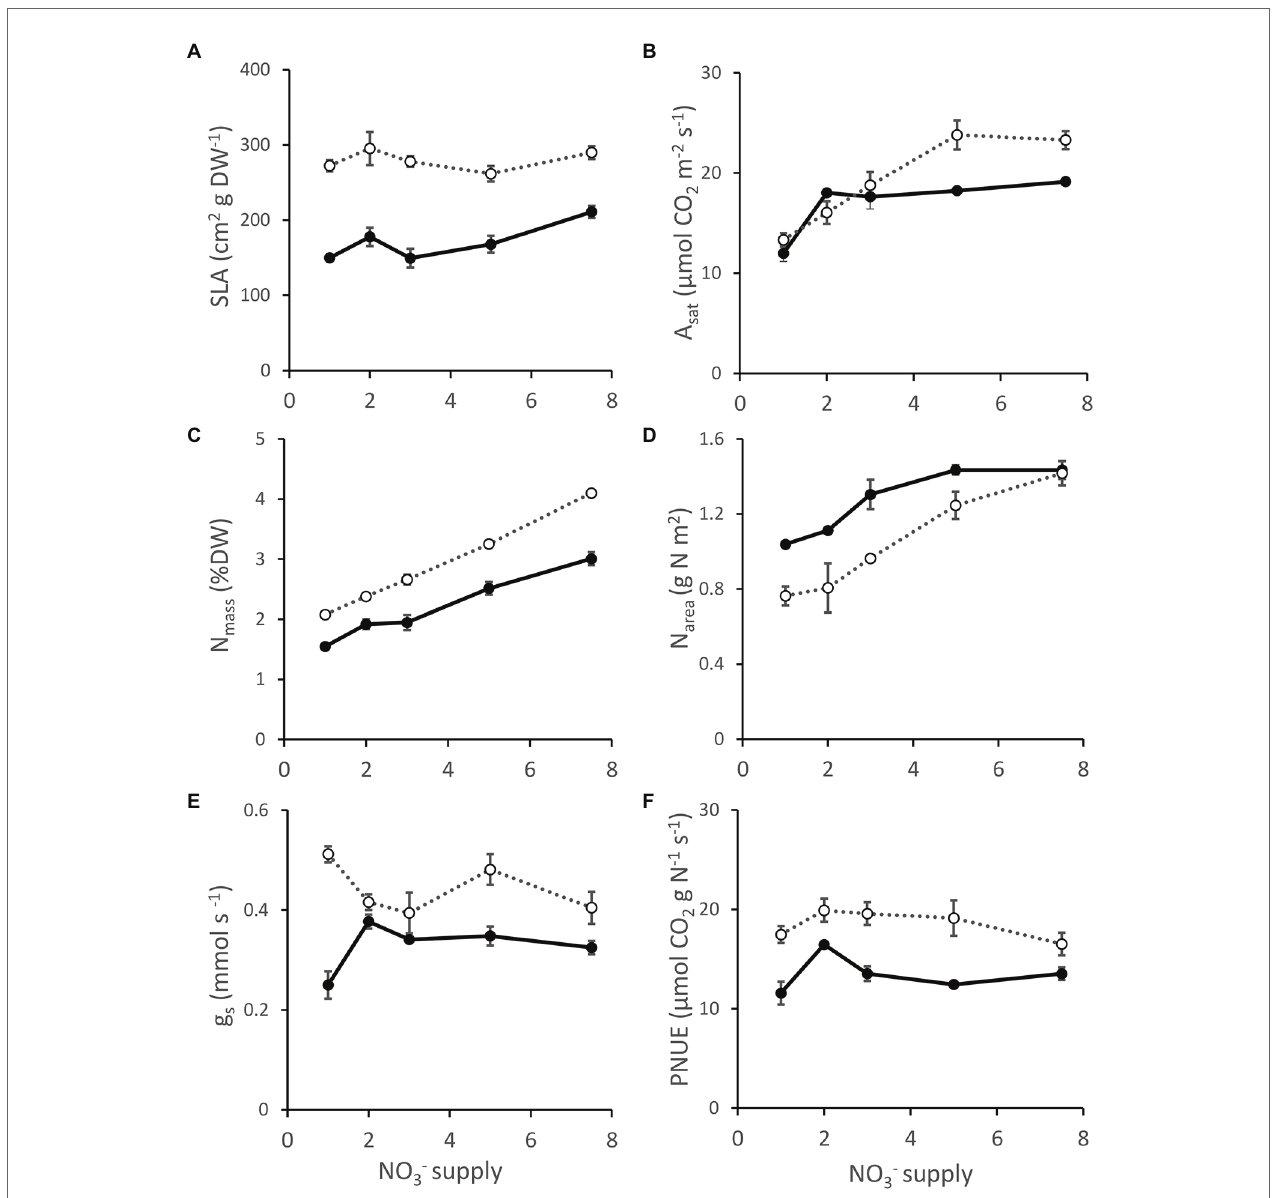
FIGURE 6 | Specific leaf area (SLA; A ), photosynthesis at 1500 μ mol photons m -2 s -1 (A sat ; B ), leaf N concentration (N mass ; C ), N per unit leaf area (N area ; D ), stomatal conductance (g s ; E ) and photosynthetic nitrogen use efficiency (PNUE sat ; F ) for L. perenne DGAT + CO5 (open circles ) and NT control (NT3; closed circles ) grown under 1-7 mM NO 3- supply. Means ± SE; n = 3 for 1, 2, and 3 mM treated plants, n = 5 for 5 and 7.5 mM treated